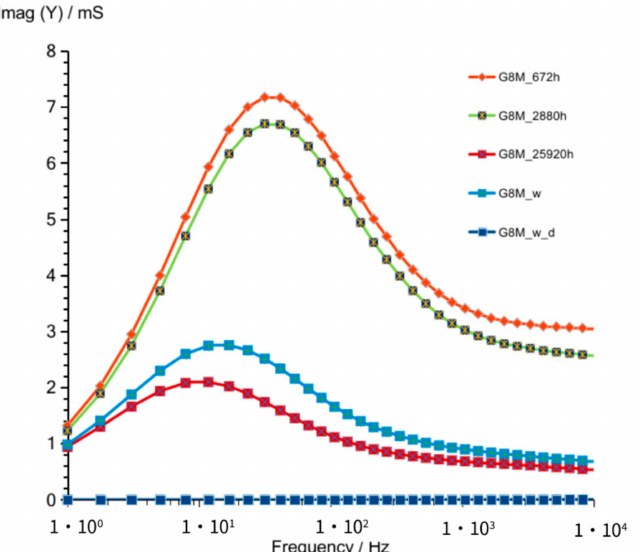
Figure 5. Susceptance of G8M geopolymer concrete taken after 672 to 25,920 h from starting poly- merization after removing conductive ions (G8M_w) and drying concrete (G8M_w_d).